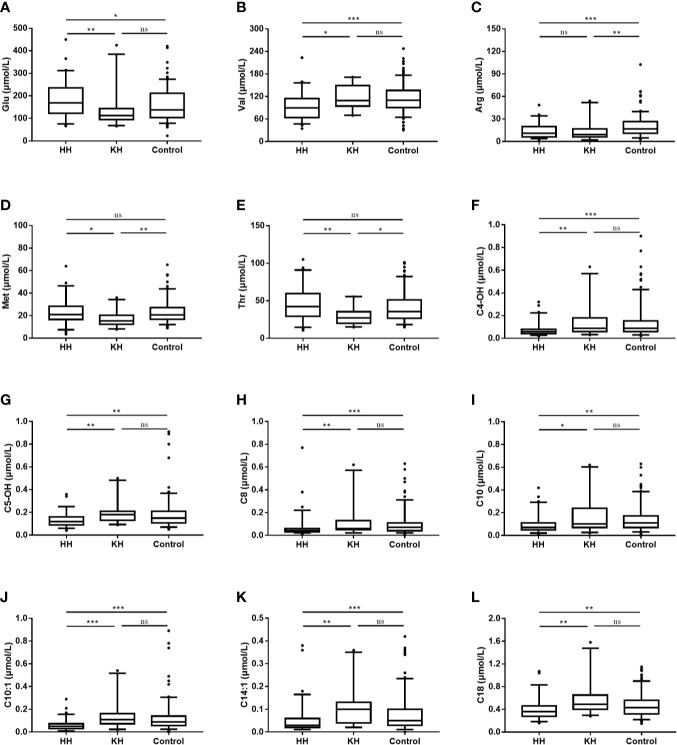
Differences in amino acid and acylcarnitine concentrations at normoglycemia among the ketotic hypoglycemia, hyperinsulinemic hypoglycemia and control groups. The box plots show the median (horizontal line), interquartile range (box), 5th percentiles (whiskers), 95th percentiles (whiskers), and outliers outside the 5th and 95th percentiles (dots). *p < 0.05 when the two groups were compared. **p < 0.01 when the two groups were compared. ***p < 0.001 when the two groups were compared. NS, Not significant; HH, hyperinsulinemic hypoglycemia; KH, ketotic hypoglycemia. (A) Blood glucsoce, (B) Valine, (C) Arginine, (D) Methionine, (E) Threonine, (F) Hydroxybutyrylcarnitine, (G) 3-Hydroxyisovalerylcarnitine/2-methyl-3-hydroxybutyrylcarnitine, (H) Octanoylcarnitine, (I) Decanoylcarnitine, (J) Decenoylcarnitine, (K) Tetradecenoylcarnitine, (L) Octadecanoylcarnitine.